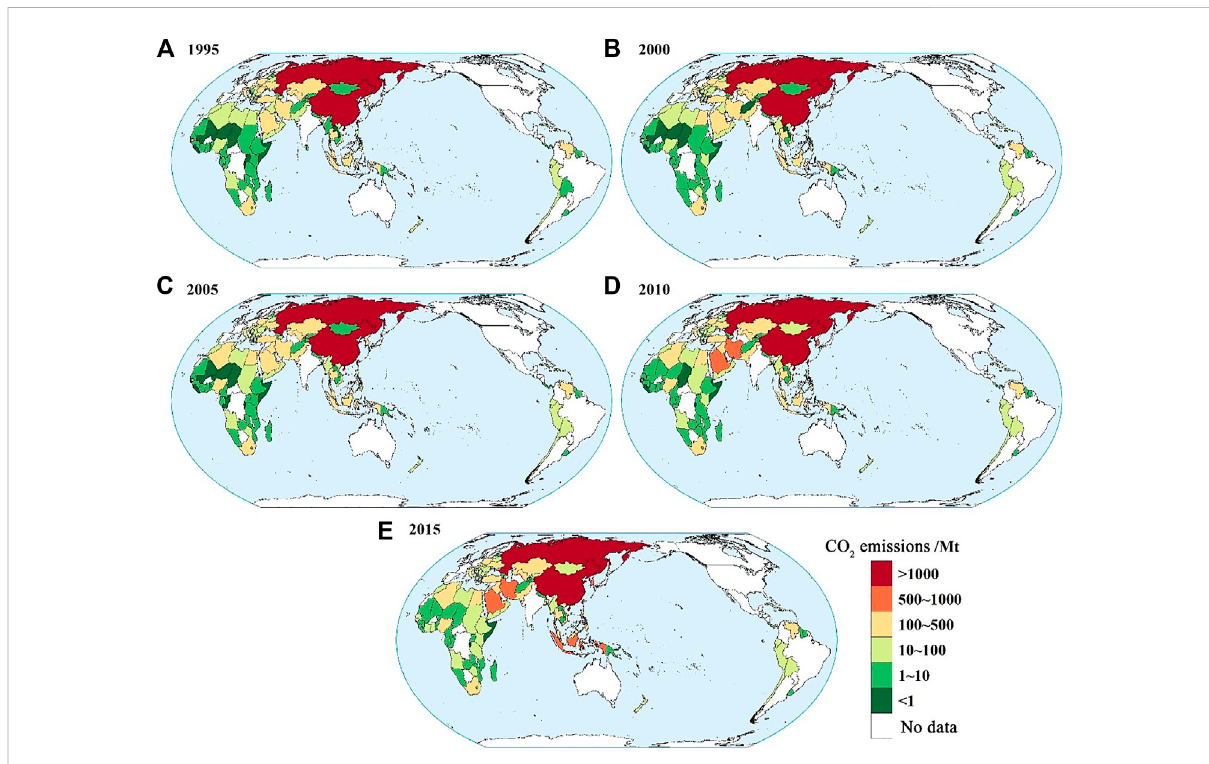
FIGURE 2 Production-based carbon emission distribution of the Belt and Road